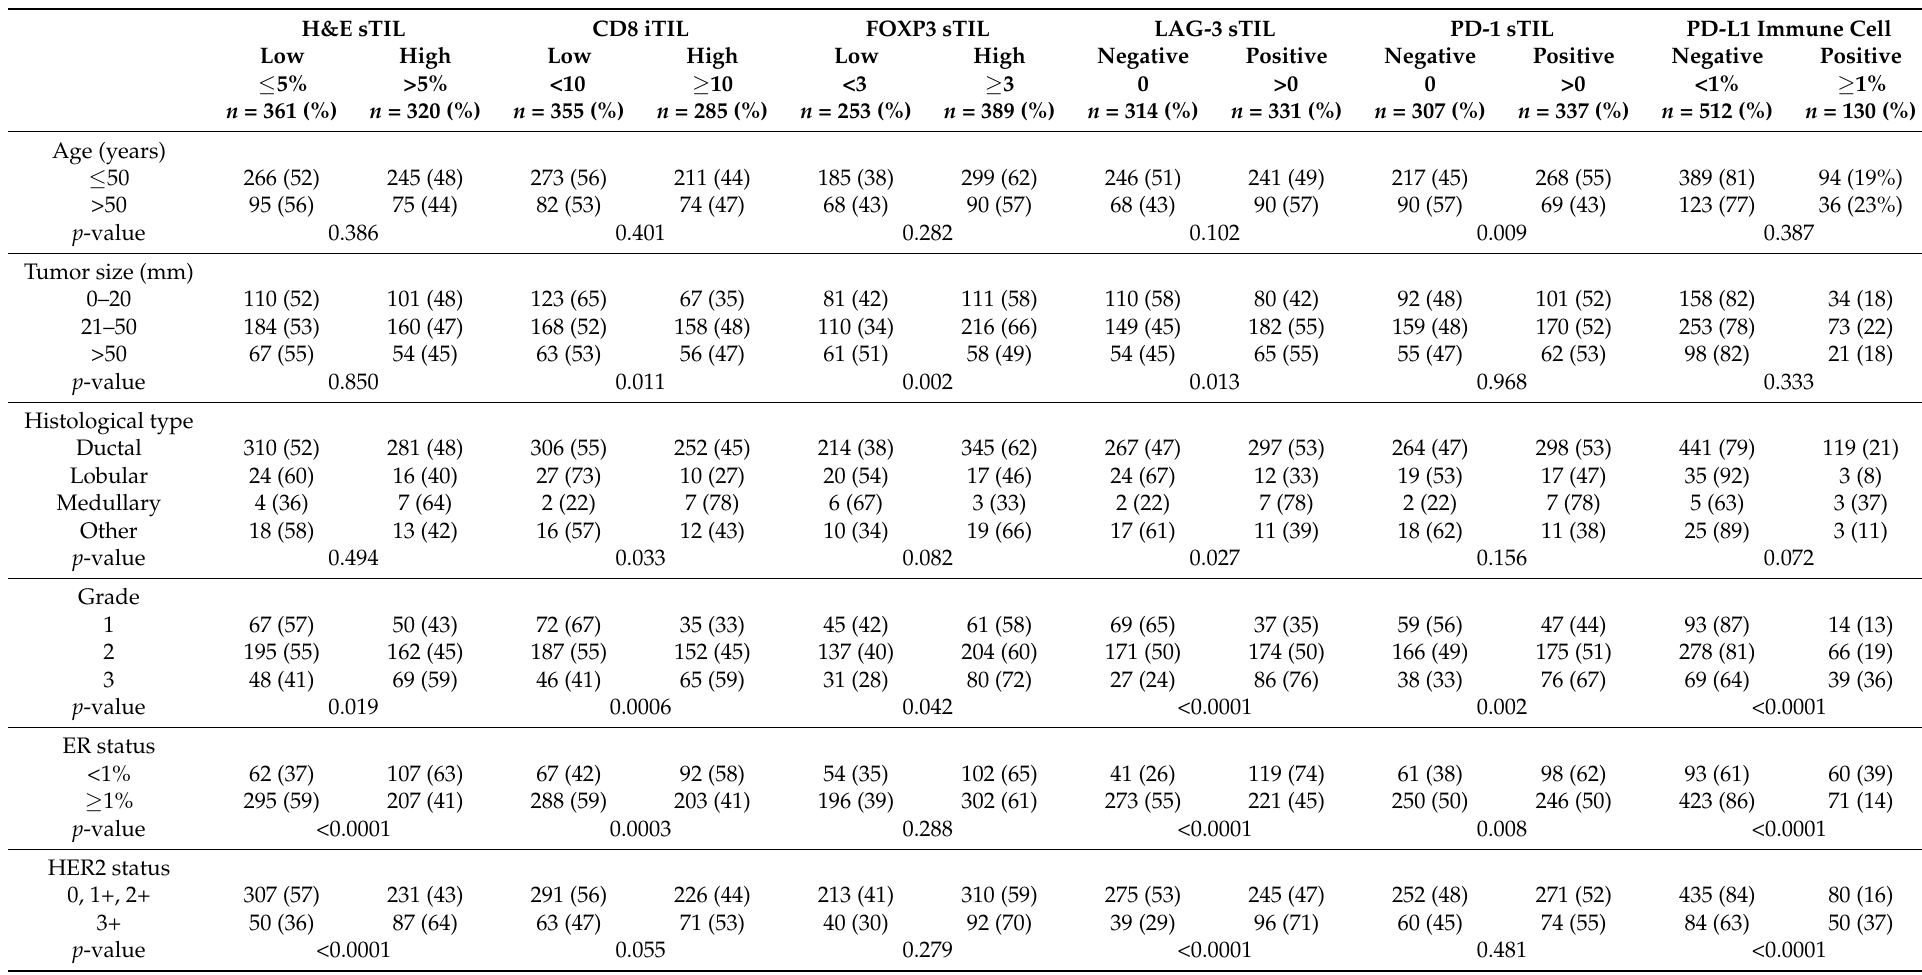
Table 1. Correlation of primary and secondary biomarkers with clinicopathological characteristics, histological subtypes and treatment groups. Percentage of cases within the given factor is shown in parentheses. Cases with unknown characteristics are not shown in the table. sTIL: stromal tumor-infiltrating